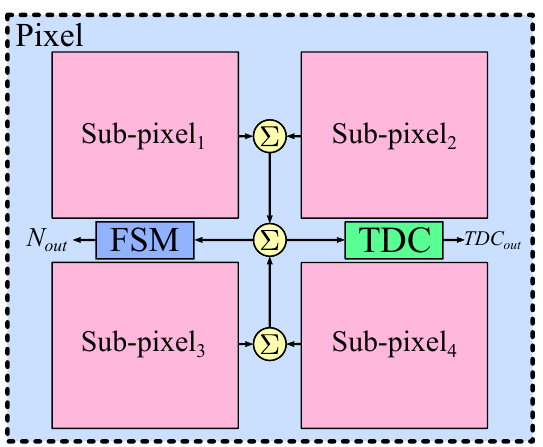
Figure 4. Simplified diagram of a digital SiPM pixel with an adder tree of two levels and the SPADs clustered into four sub-pixels. Each pixel provides both the number of counted photons ( N out ) and the arrival time of the incident particle ( TDC out